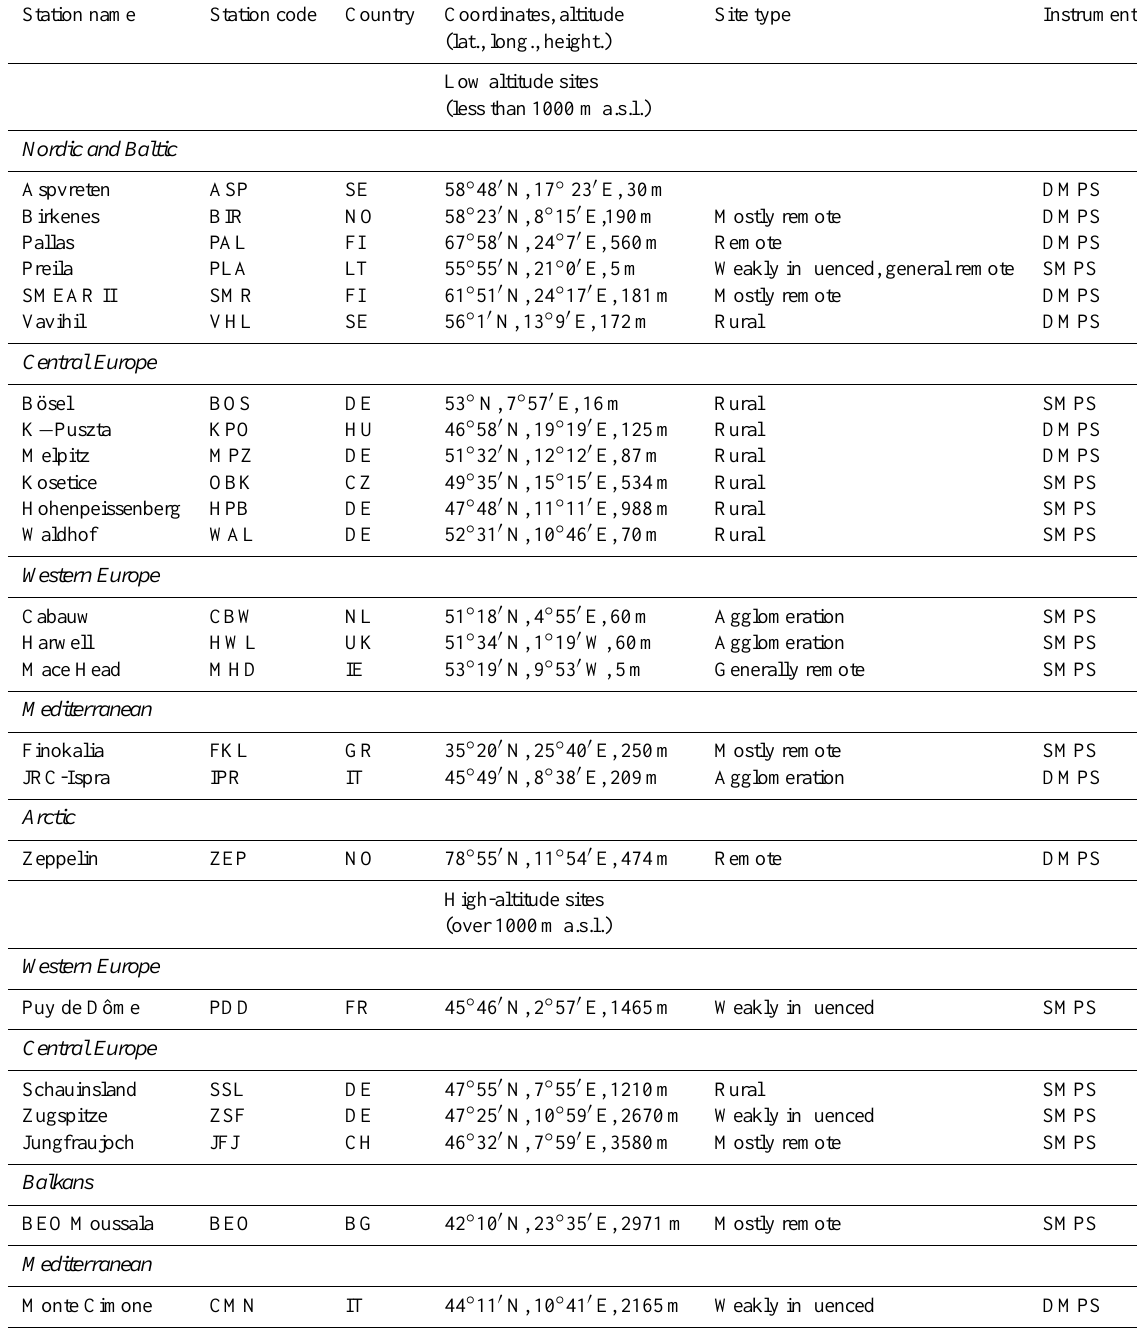
Table 1. Locations and names of stations used in the data analysis. The site altitudes are given with reference to standard sea level. The areas are grouped by European sub-divisions using definitions from the Central Intelligence Agency (2013). Country codes are given in the ISO 3166